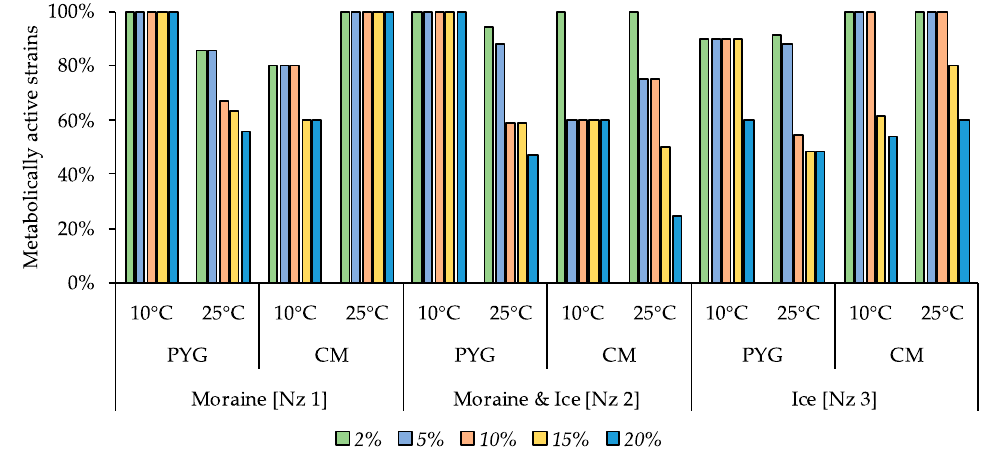
Figure 10. Isolated strains’ resistance to the presence of magnesium sulphate in nutrient medium. Vertical axis: proportion of the strains in the culturable community able to reproduce in considered conditions. Horizontal axis: the tested communities. Temperature and medium abbreviations indicate the isolation conditions. PYG and CM—peptone yeast glucose and modified Czapek media, respectively.